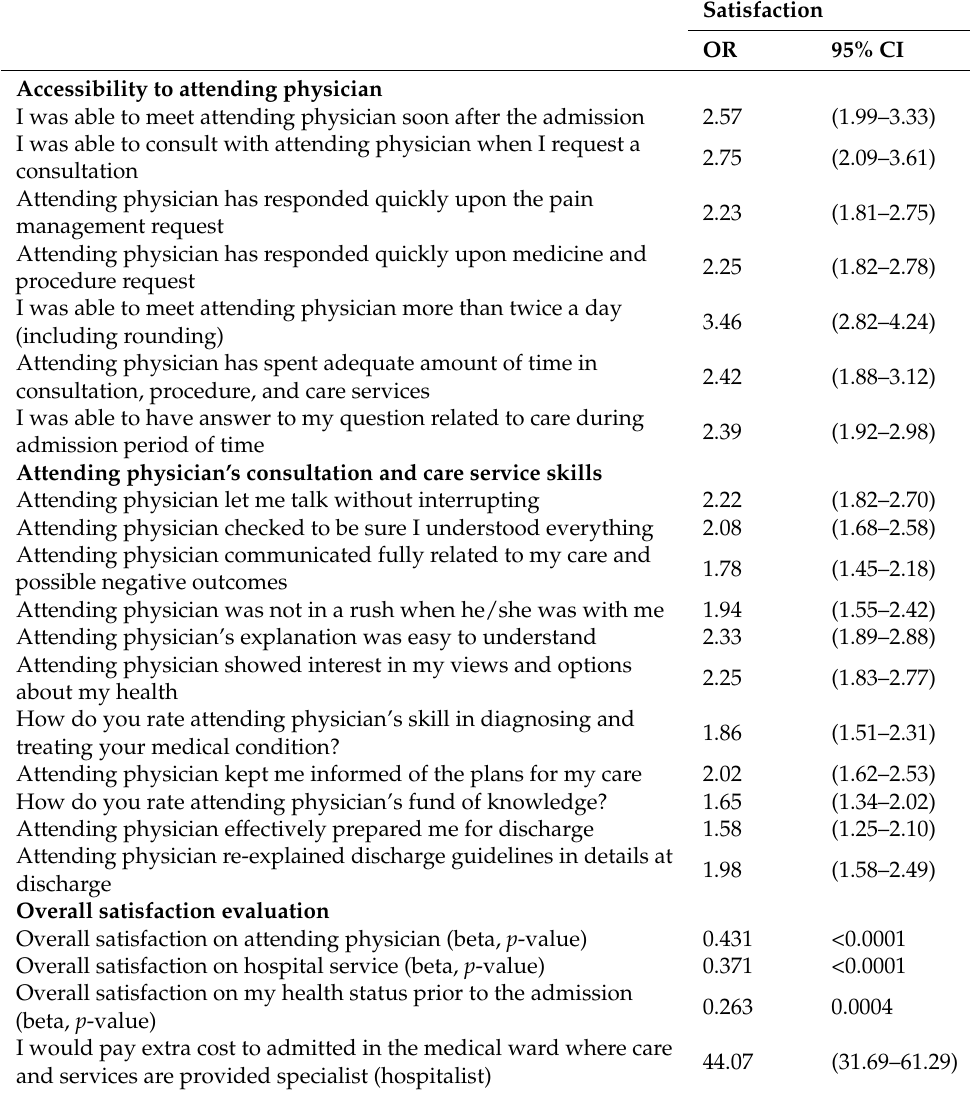
Table 2. Results of logistic regression on the patient satisfaction on attending physician in the hospitalist ward compared to the non-hospitalist ward ‡